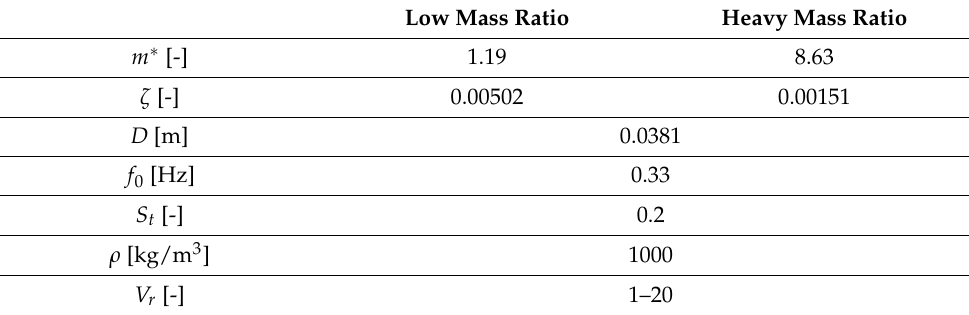
Table 1. Simulation parameters, free oscillations